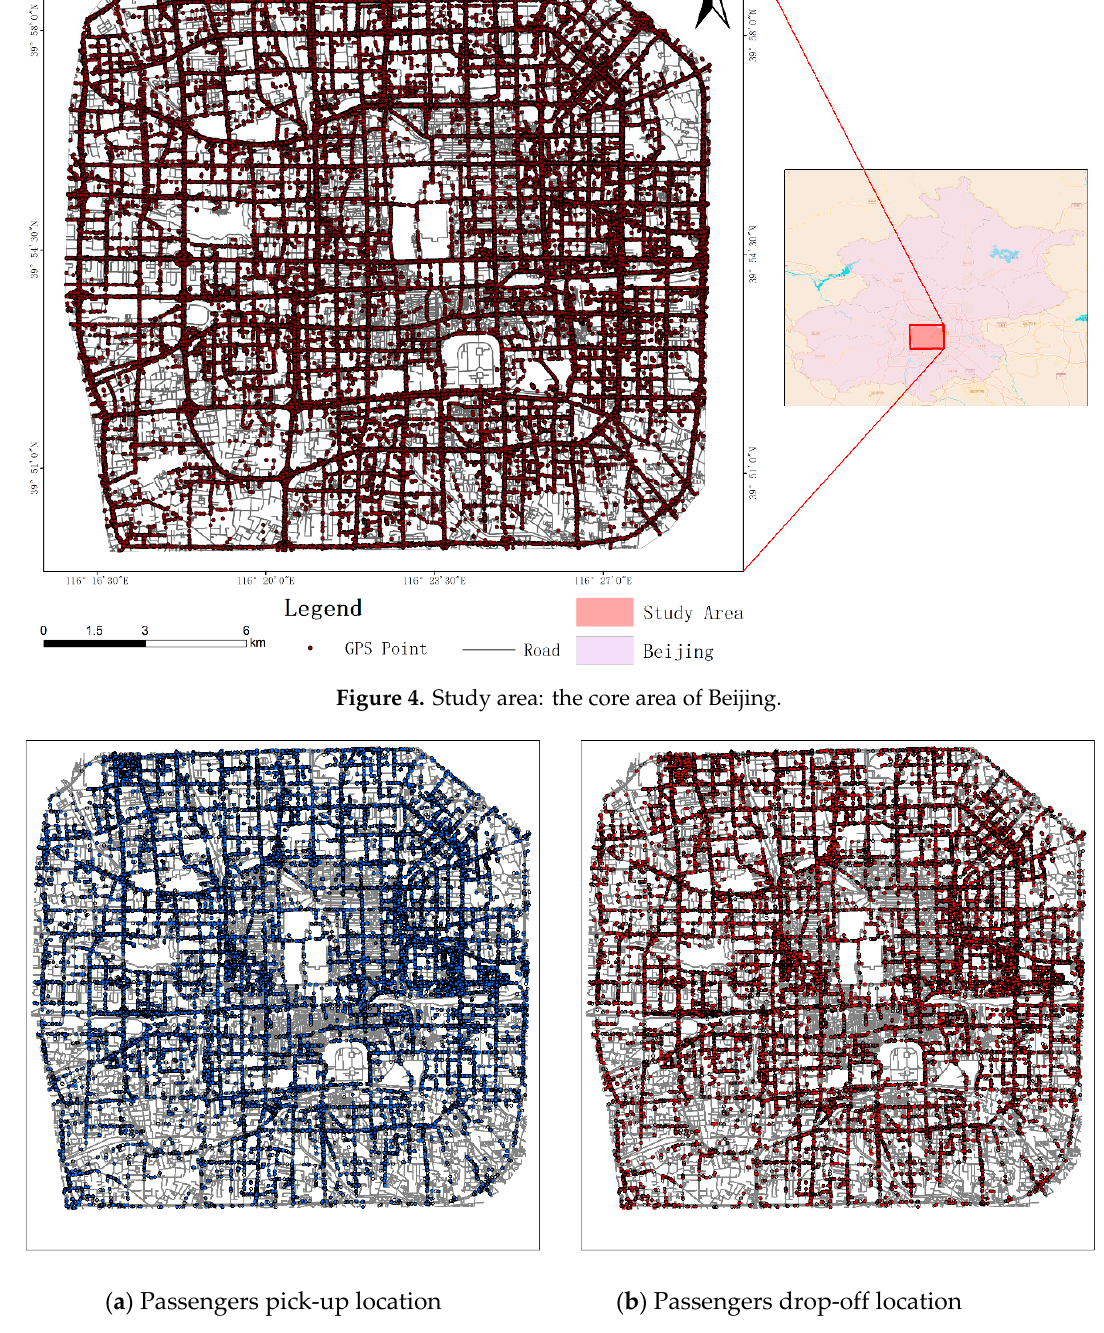
Figure 5. Passengers pick-up/drop-off points.